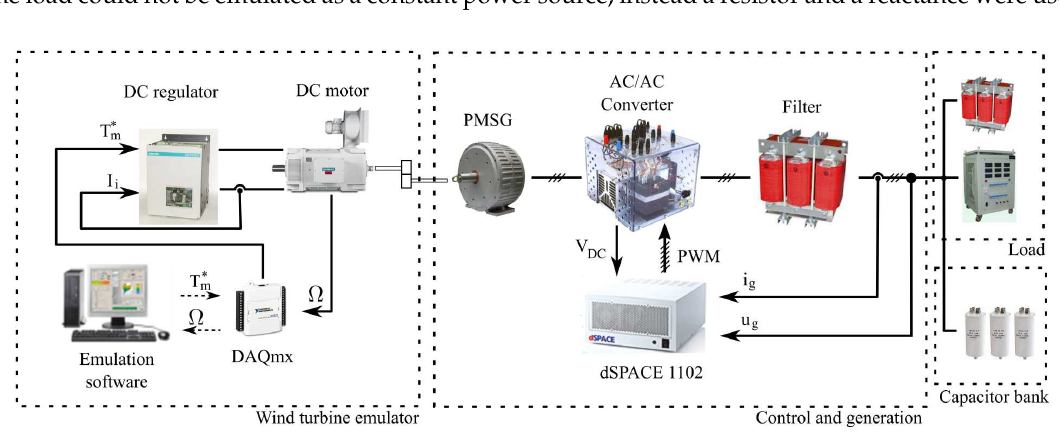
Figure 7. Test bench used for real-time experiments. PWM: pulse-width